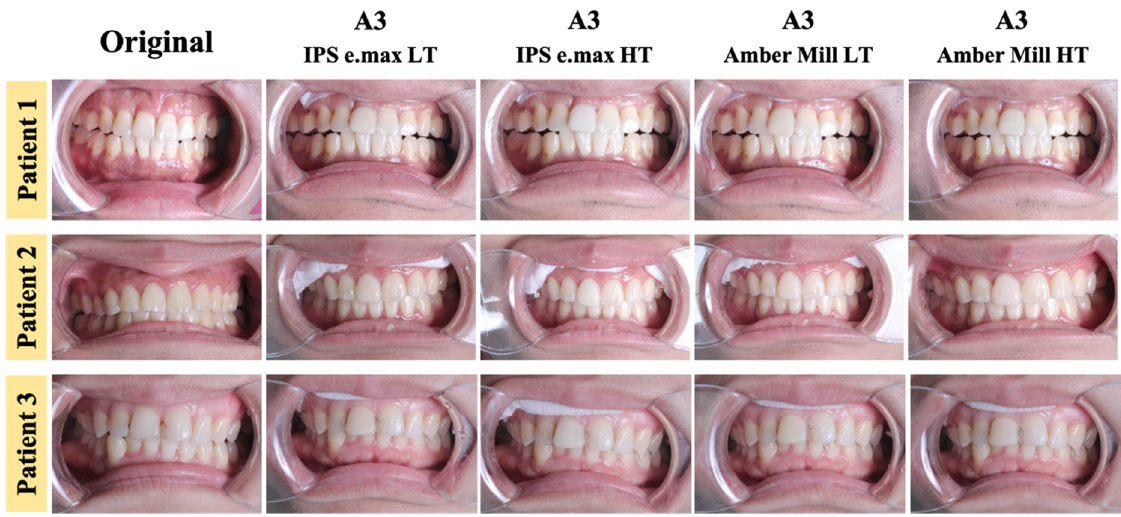
Figure 11. Optical images of A3 color glass-ceramics placed in the human oral cavity.